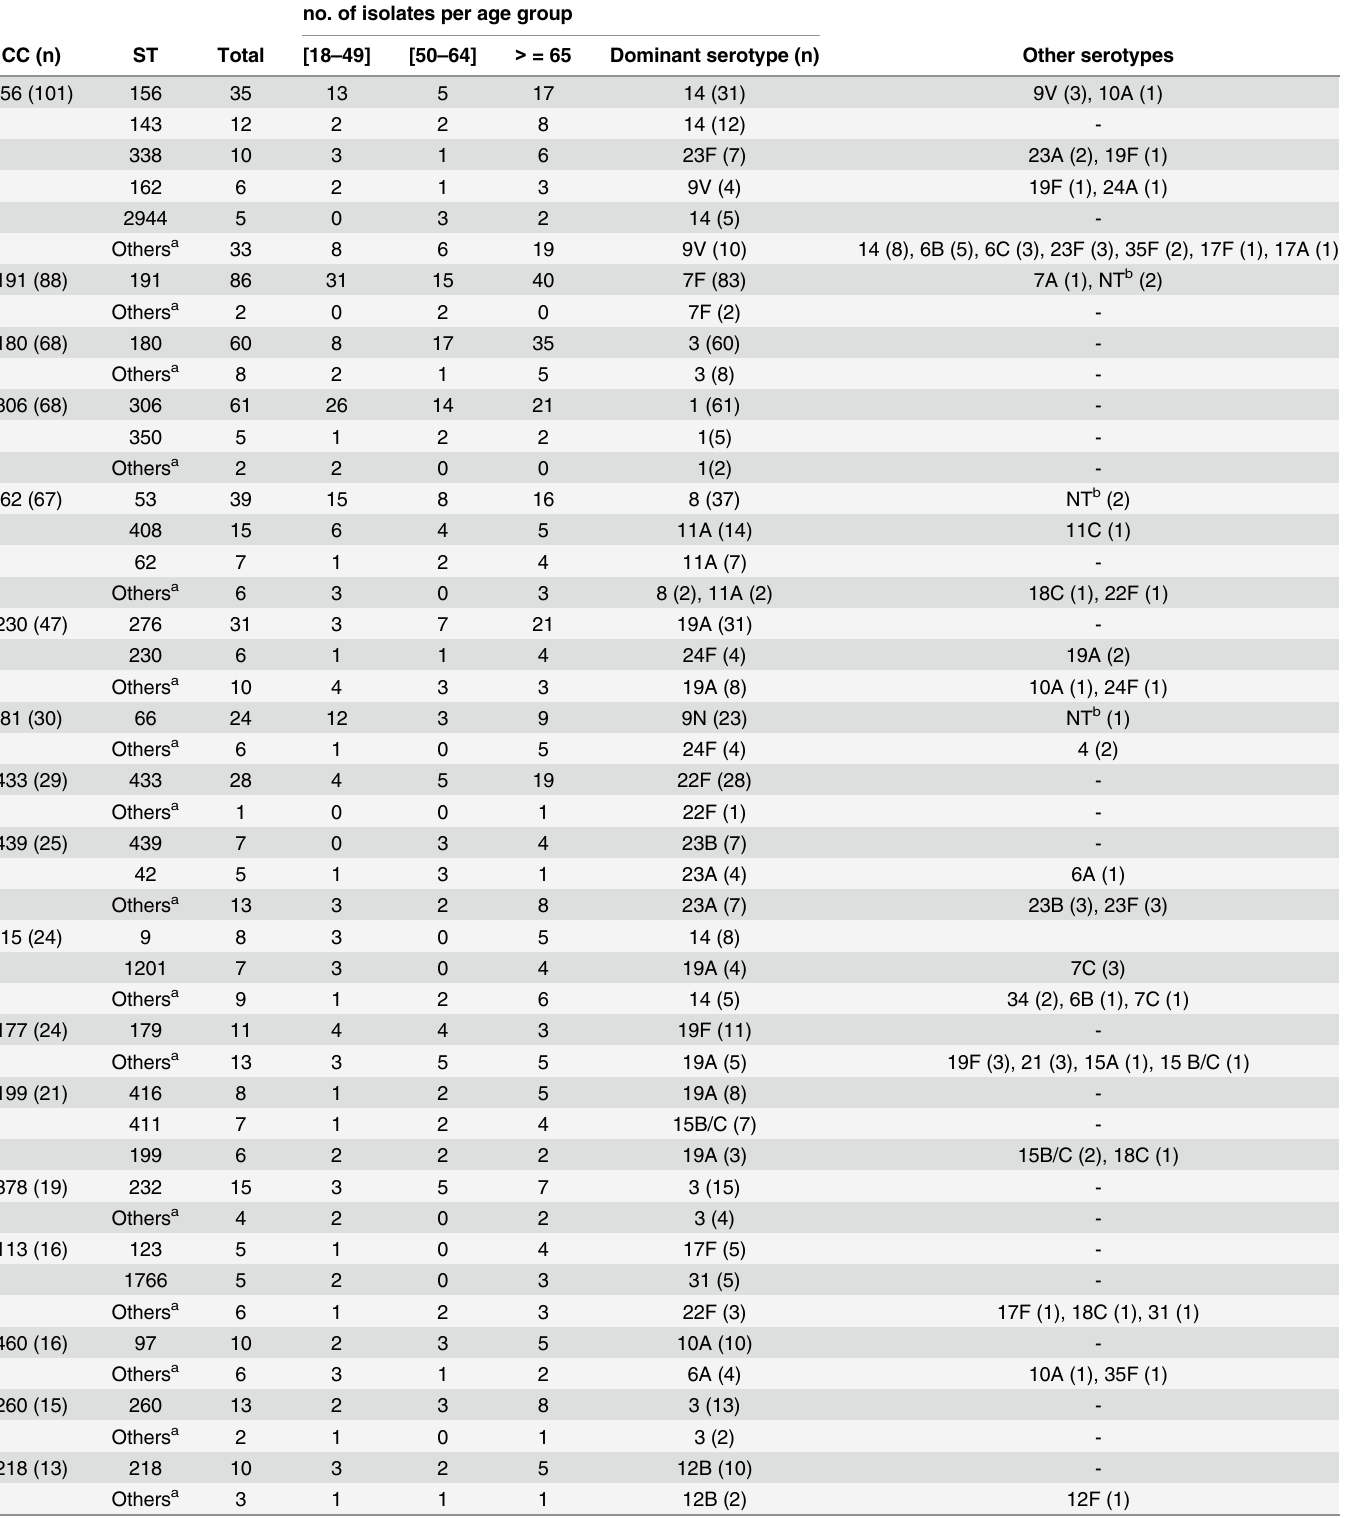
Table 1. Age distribution and the serotypes of the most frequent STs found in the 22 major CCs (n (cid:1) 10 isolates) identified by goeBURST. no. of isolates per age